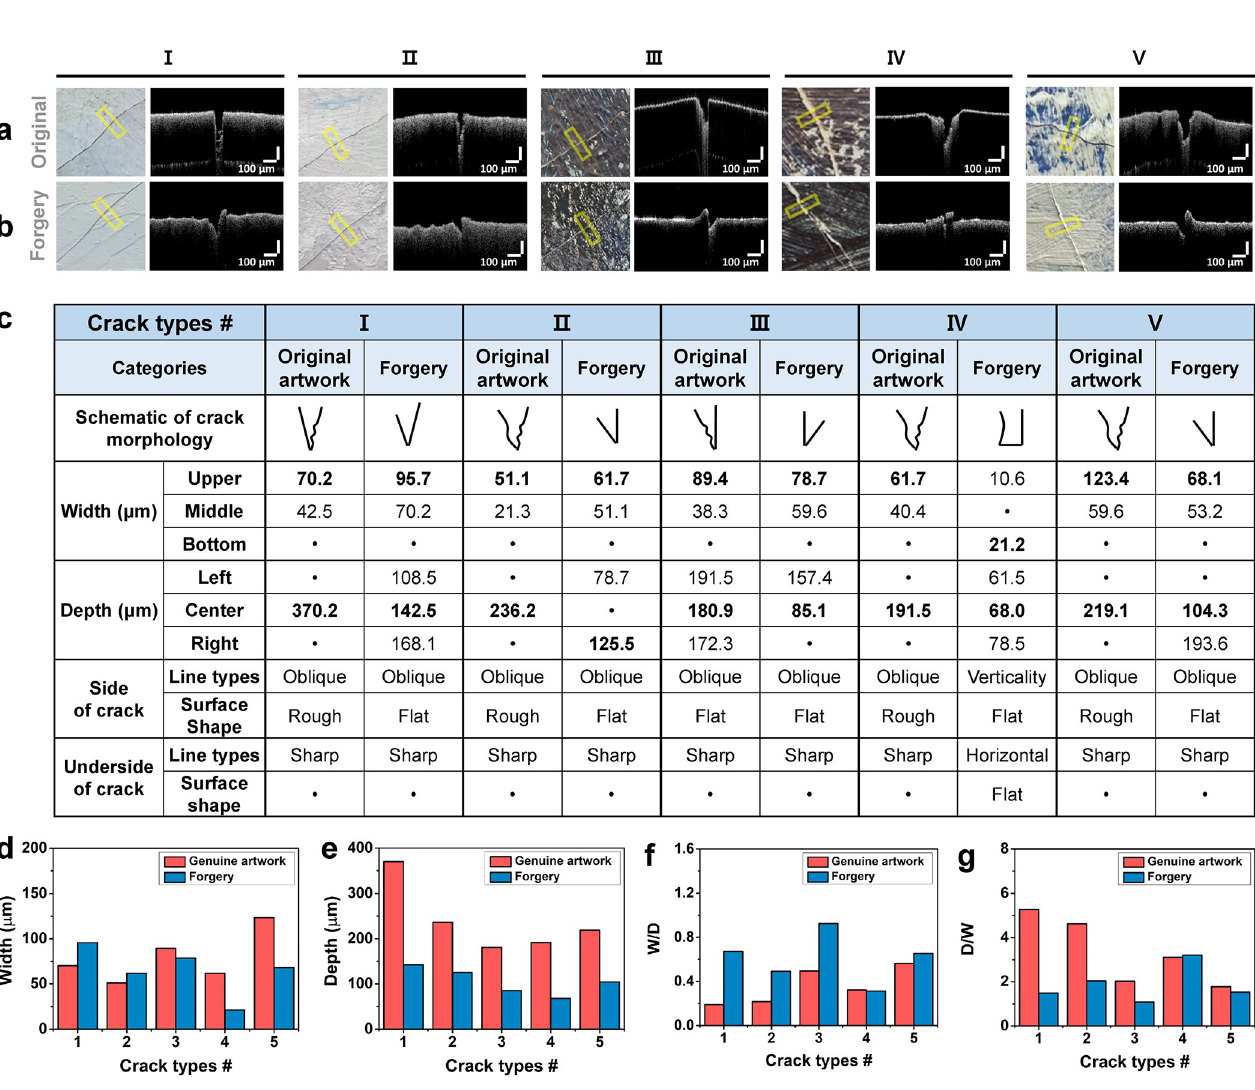
Fig 6. Comparison between the OCT cross-sectional images of (a) the original and (b) forged artworks for art authentication. (c) Quantitative analysis of the OCT cross-section images of the original and forged cracks of Artwork 3 . The representative values of the dimensions of the original and forged cracks selected for analysis were compared by (d) width, (e) depth, (f) width/depth, and (g) depth/width. ( Ⅰ ) Cracks caused by the aging canvas made in areas covered in a thin layer of paint. ( Ⅱ ) Cracks caused by the aging canvas made in areas where the paint layer was relatively thicker. ( Ⅲ ) Cracks caused by the drying paint layer and made in areas with a thin layer. ( Ⅳ ) Cracks made by applying a physical impact to the paint layer. ( Ⅴ ) Cracks caused by the drying of the paint layer and made in area with a thick layer. The side paint layer of the forged cracks protrudes and has a much shallower inverted triangle shape than the original